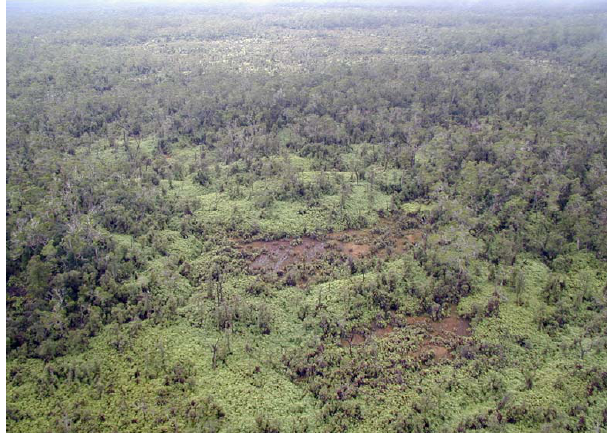
Fig. 13a. Aerial view of cohort mosaic on east slope of Mauna Kea with two bogs and gap-formation dieback with Dicranopteris fern patches underneath dying Metrosideros tree groups (photo by Rick Warshauer, April 2005).